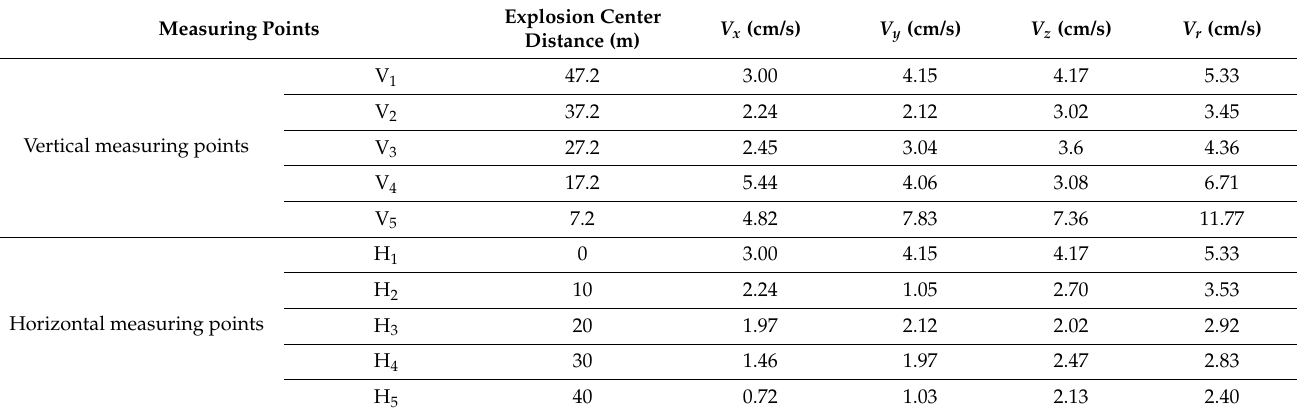
Table 7. The PPVs of measuring points.